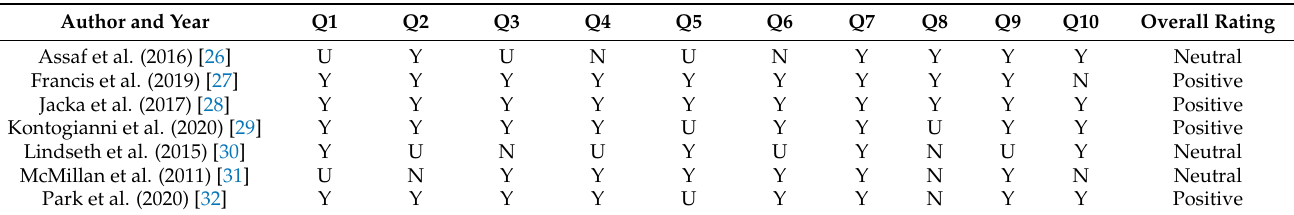
Table 1. Quality assessment of included